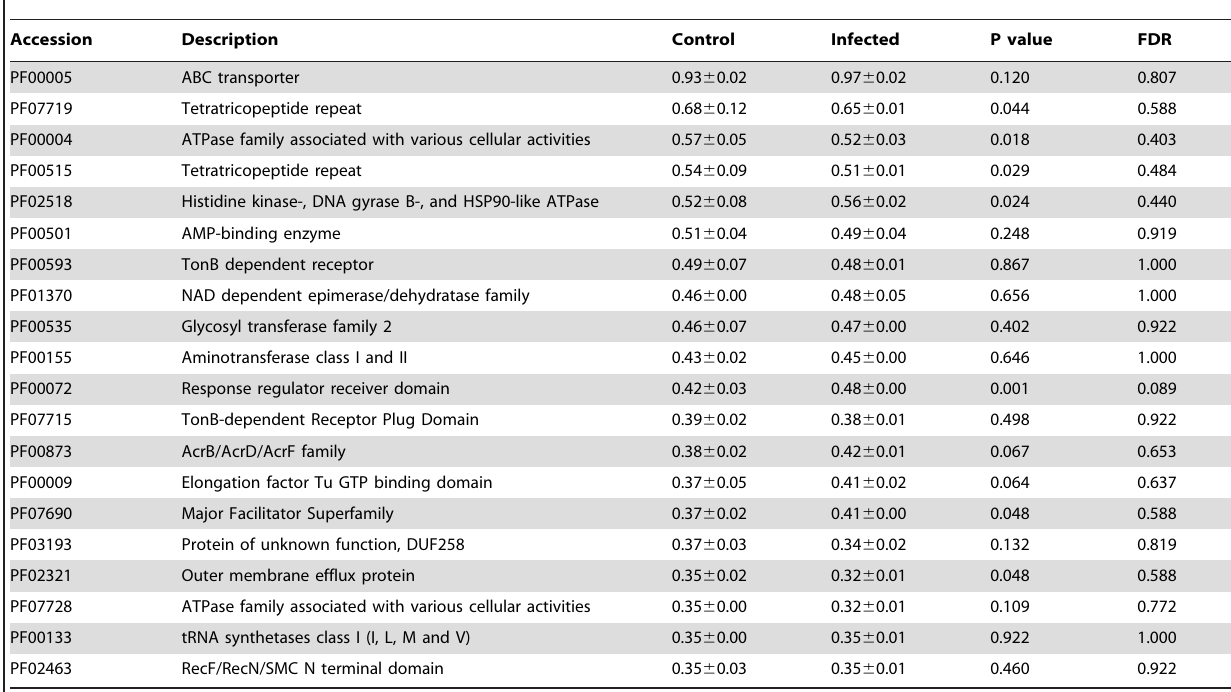
Table 3. The 20 most abundant Pfam protein families in the bovine abomasal microbiota of immune animals.